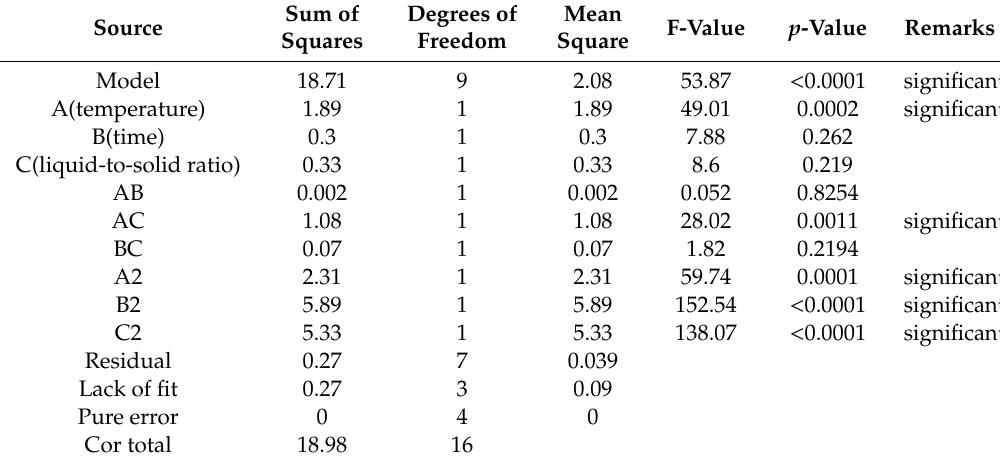
Table 2. Analysis of variance (ANOVA) for the second-order response surface model. Sum of Source